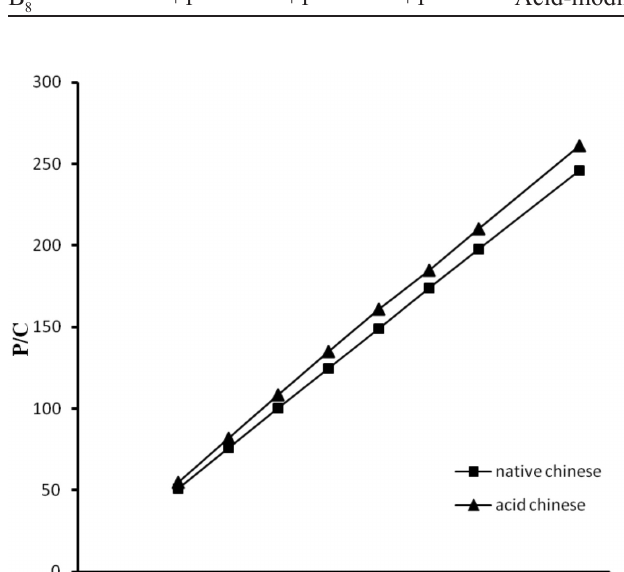
TABLE V - Summary of the individual and